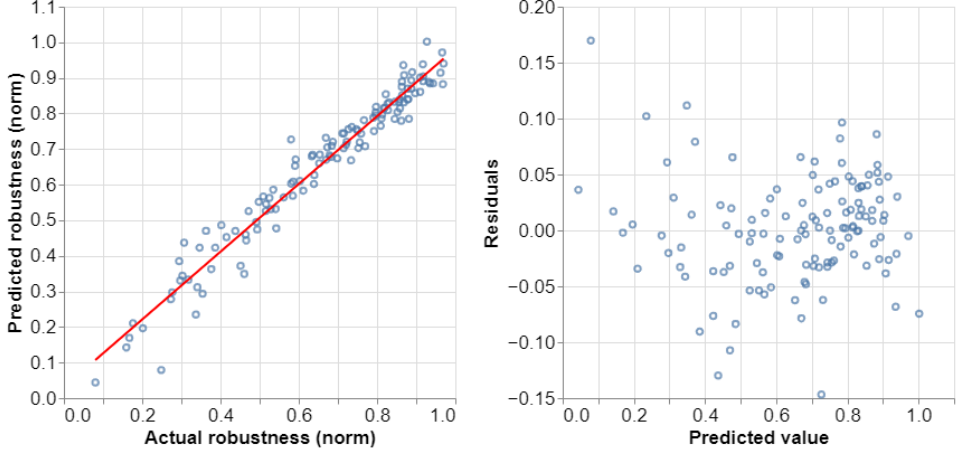
Figure 4. Residual analysis of the LR model (best identified RM ) with 125 test